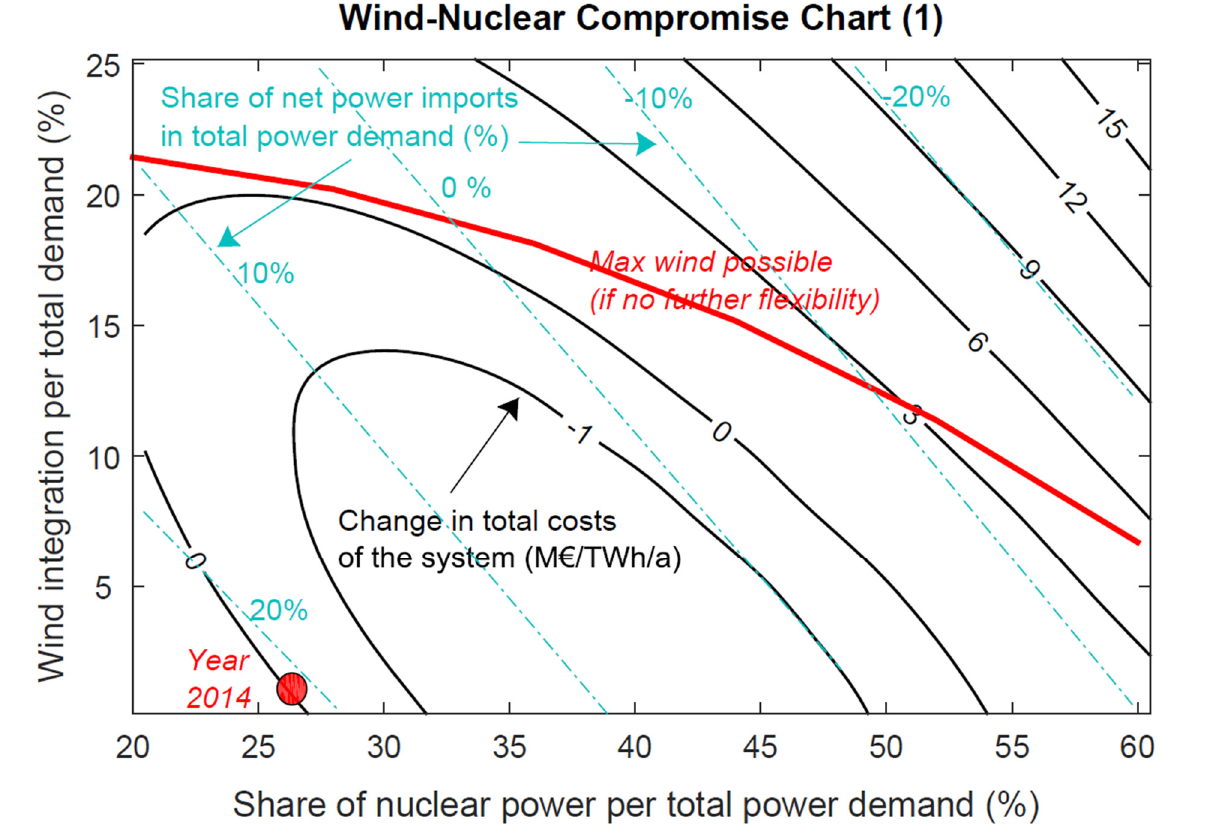
Figure 10. Wind-nuclear compromise chart with respect to self-sufficiency in power supply and total costs of the energy system (max wind possible (red curve), share of net power imports per total electricity demand (blue dash lines), change in total costs of the energy system compared to 2014 (per unit of annual power demand, M€/TWh/a) (black line)). The state of the energy system in 2014 is highlighted with a red circle. For wind-nuclear compromise chart (2), the reader may refer to Figure C1, Appendix